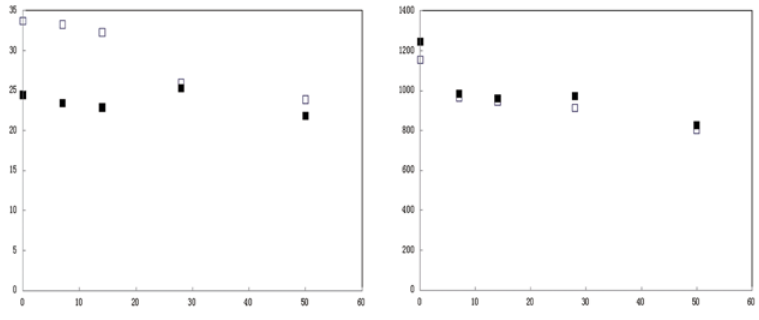
Fig 5. TCLP extractable Cd concentration (left) and soil available phosphate (right) in DAP treated soils and MPP treated soils.